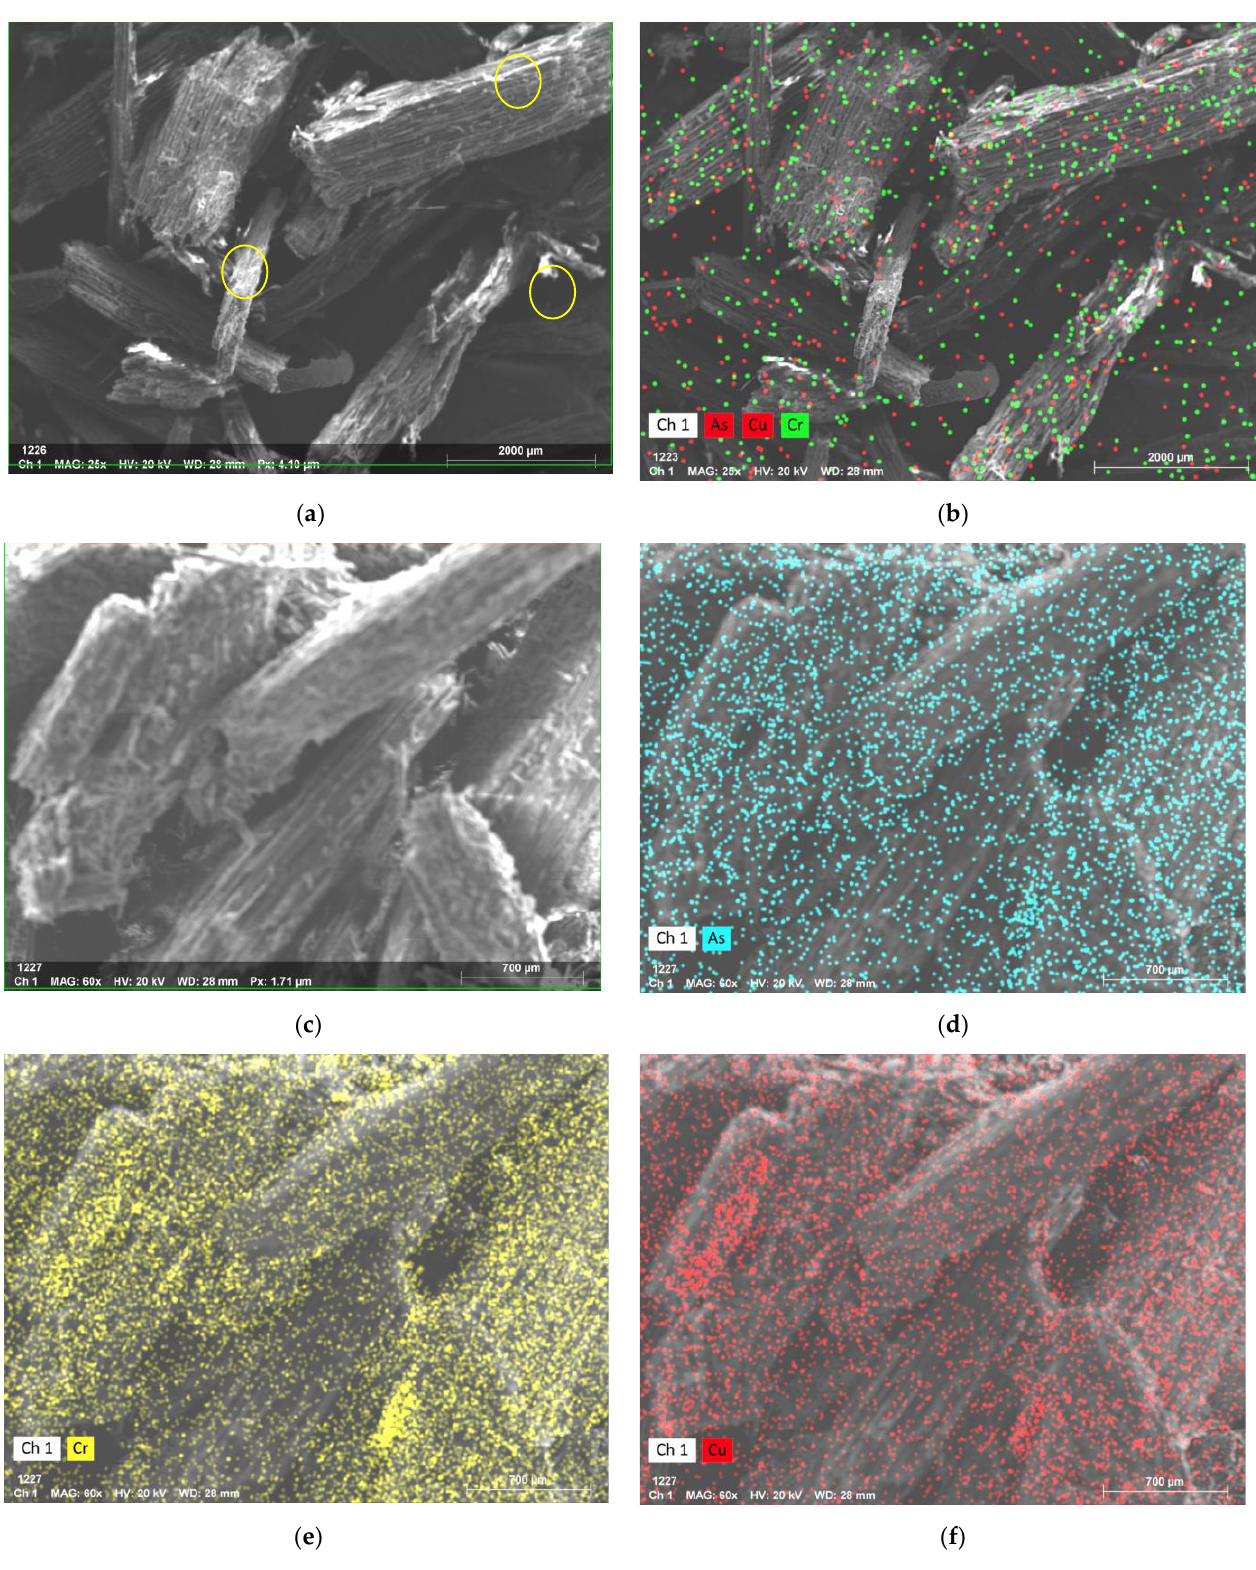
Figure 2. Scanning electron microscopy (SEM) facias of ( a ) CCA-treated wood showing As, Cr, or Cu metals identified by circles; ( b ) the dispersion of As, Cr, and Cu in the CCA-treated wood; ( c ) Biochar showing multiple spots of metals; ( d ) The dispersion of As in biochar; ( e ) The dispersion of Cr in biochar; ( f ) The dispersion of Cu in